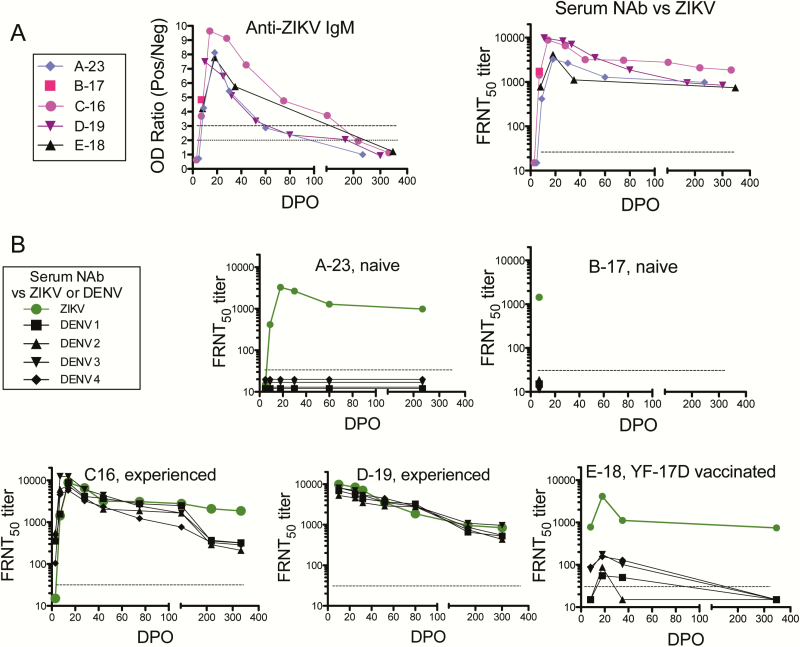
Antibody responses. A, Serum anti–Zika virus (ZIKV) immunoglobulin (Ig) M was determined by Zika IgM antibody-capture-enzyme-linked immunosorbent assay (MAC-ELISA) and serum neutralizing antibody (NAb) against ZIKV by focus reduction neutralization test (FRNT). The IgM ELISA values were the ratios of the patients’ serum optical densities to healthy control serum optical densities; <2, negative (lower dashed horizontal line in IgM panel); 2–3, equivocal; >3, positive (upper dashed line). The dashed horizontal line in the NAb panel is the negative cutoff: a titer of <30. The FRNT50 titer is the reciprocal of the serum dilution at which a 50% reduction in viral foci was observed. B, Serum NAb against ZIKV (green symbol and line) or dengue virus-1–4 (black symbols and lines) in the FRNT. Note: subject E-18 also had a past history of extended travel in the tropics. Abbreviations: DENV, dengue virus; DPO, days post onset of symptoms; FRNT, focus reduction neutralization test; Ig, immunoglobulin; NAb, neutralizing antibody; OD, optical density; ZIKV, Zika virus.